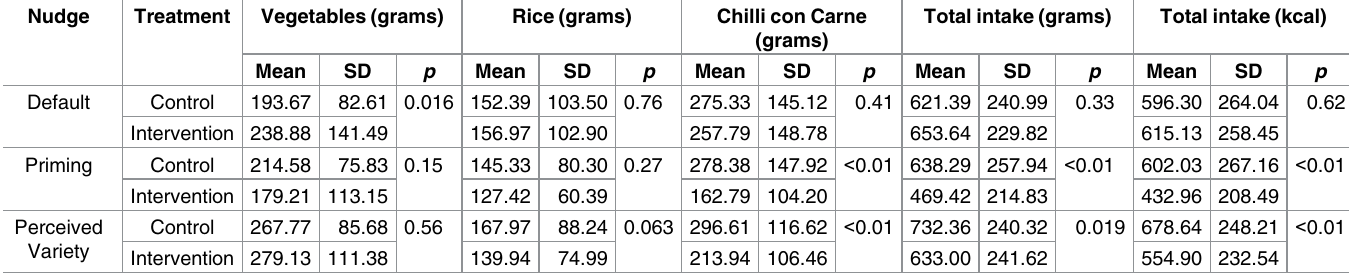
Table 3. Intake in grams (g) divided by food group: Vegetables, rice and chilli con carne. Presented using means and SD. Test of significanceusing mixed modelling.Default n = 33, Priming n = 24, Perceived variety n = 31. “How hungryare you?” and “How much do you think you can eat?” were includedas covariatesin the analysis.“Can you eat more?” was further includedas a covariate in the analysisfor the Default nudge. Nudge